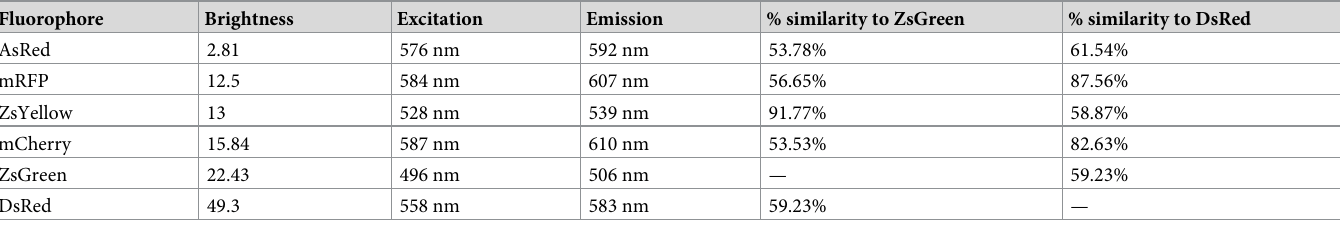
Table 1. Fluorophore properties [7, 8].